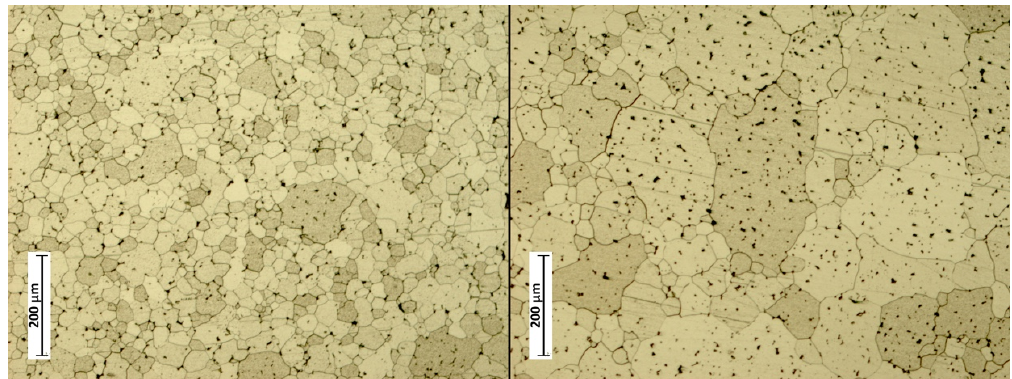
Figure 7. Microstructures after chemical etching of molybdenum powder (Mo-45) sintered at 1750 °C under 70 MPa pressure for 30 min (left: shell, right: core). Black dots are due colloidal silica used as reactant.